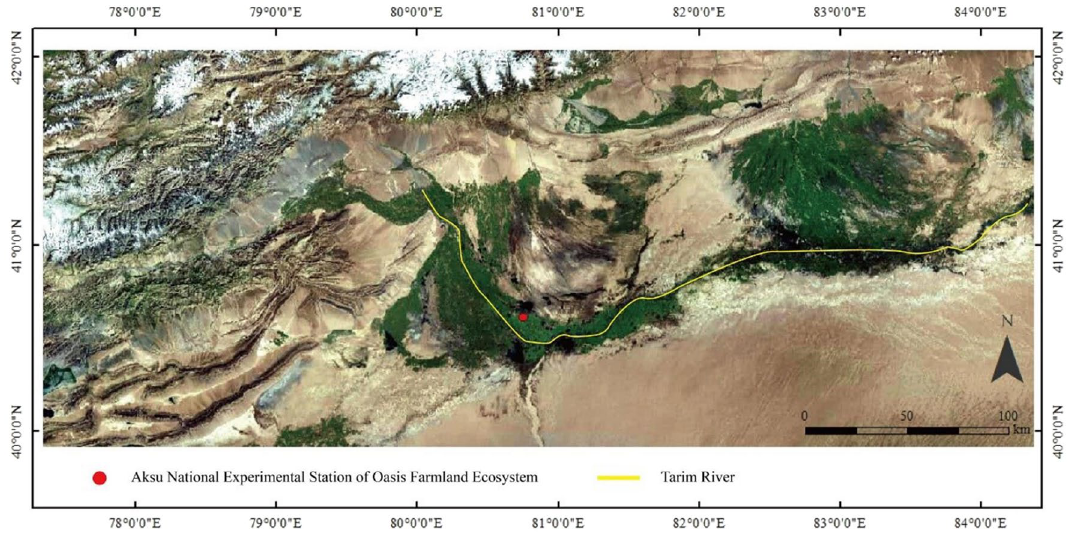
Figure 1. Location of the Aksu National Experimental Station of Oasis Farmland Ecosystem (the map was created by software: QGIS Version 3.16.15 LTR: URL, https:// www. qgis. org/ en/